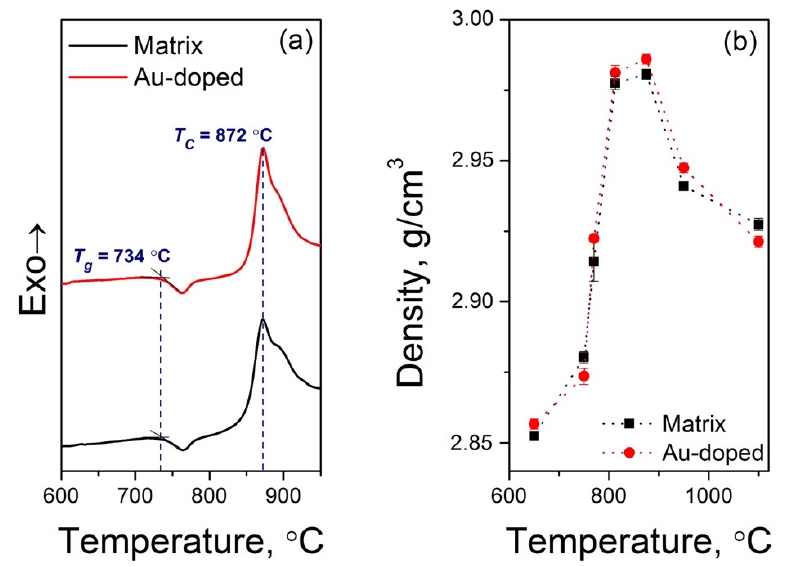
Figure 1. ( a ) DCS curves of the glass samples ( T g —glass transition temperature, T C —the temperature of the crystallization peak); ( b ) variation of density with the heat treatment temperature for the glass samples. The heat treatment duration was 20 h. The dashed lines in ( b ) serve as a guide for the eye. The error bars match the size of the symbols.